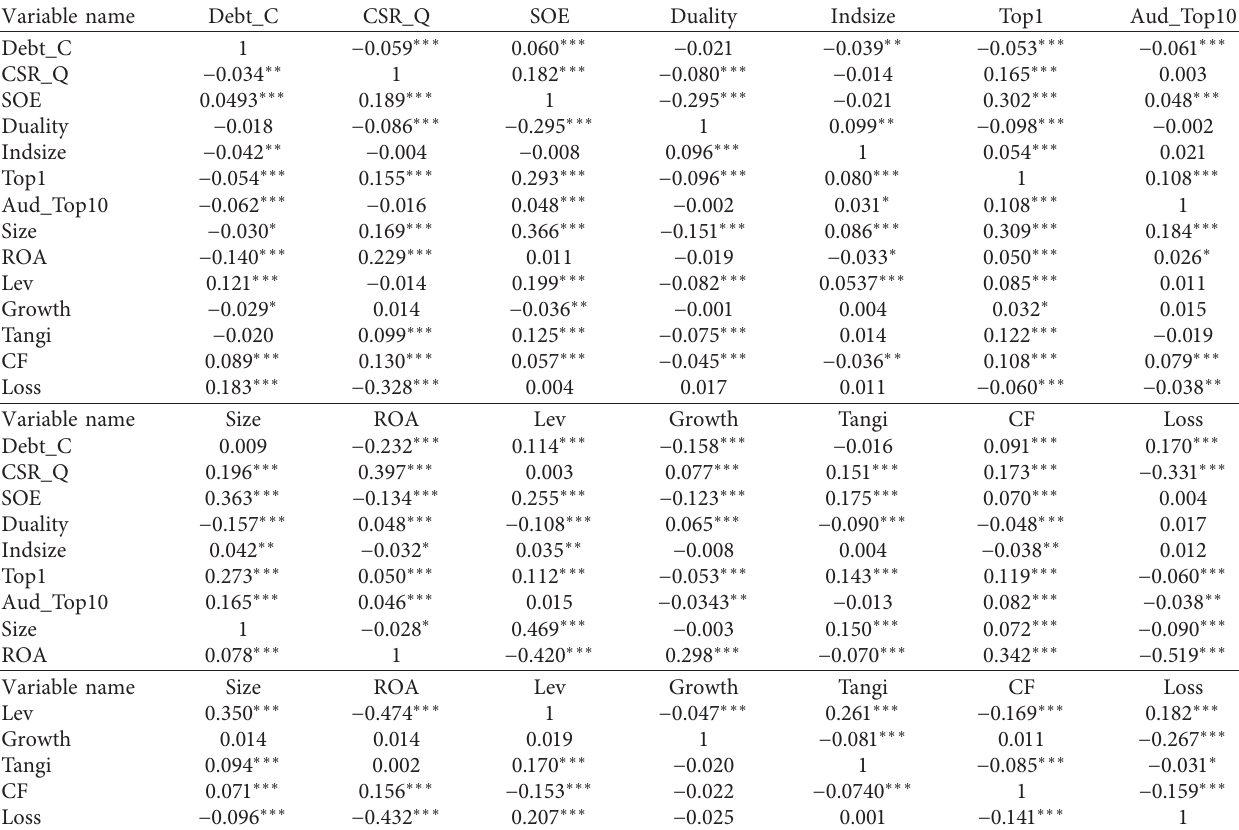
Table 3: Correlation analysis of